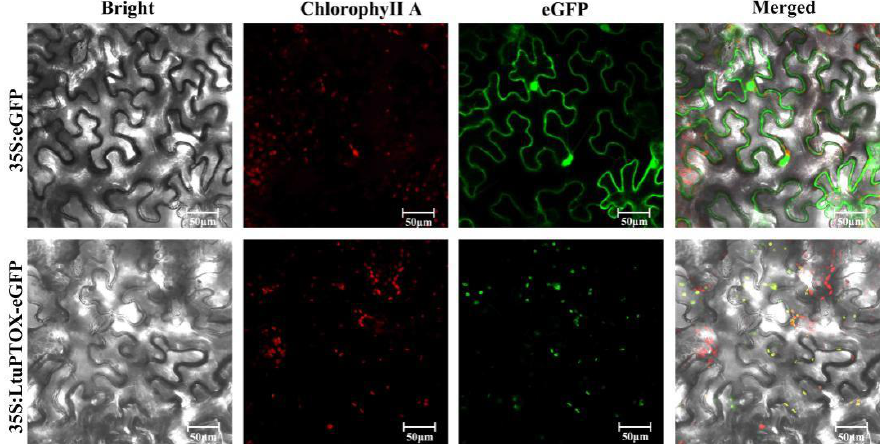
Figure 3. Subcellular localization of LtuPTOX in tobacco leaves.